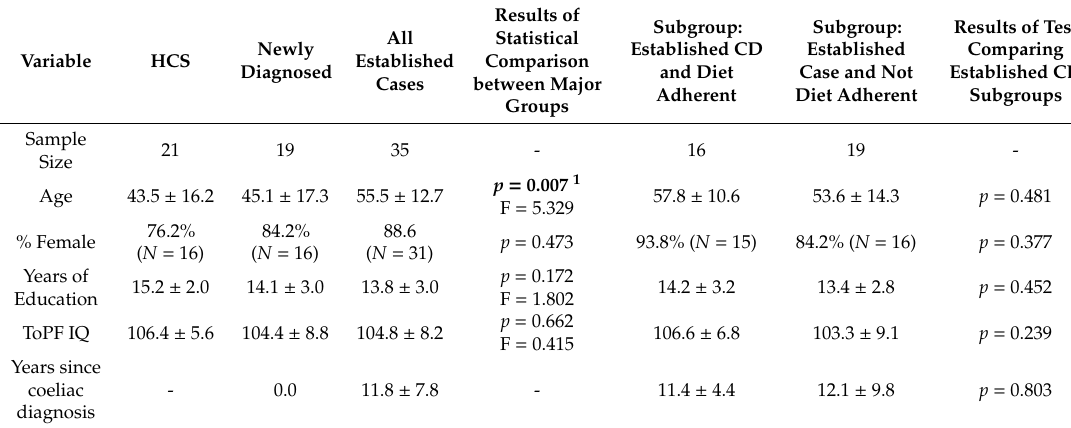
Table 1. Demographics of the study